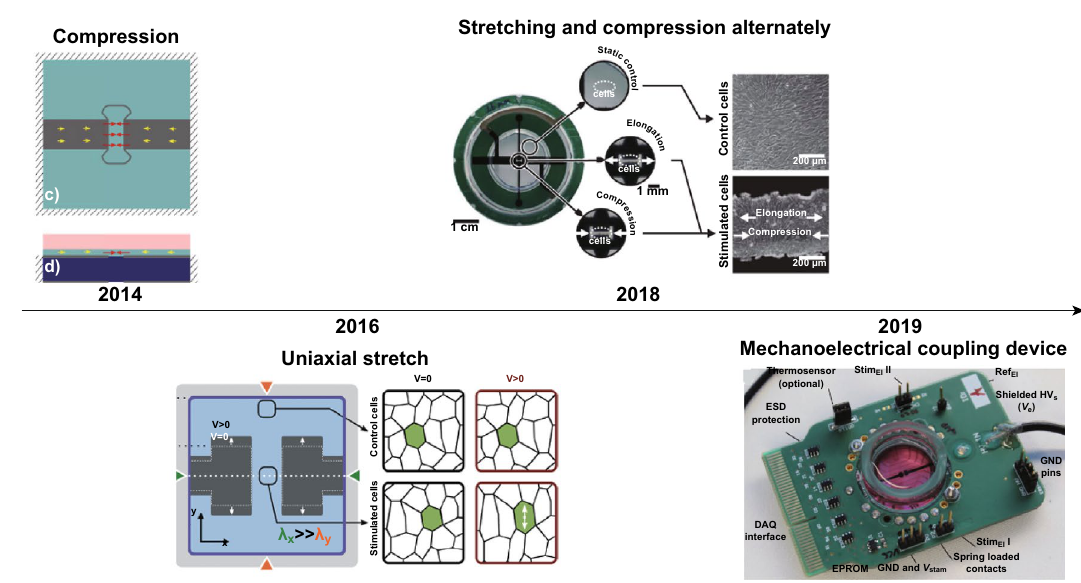
Fig. 6 The DEA devices for cellular stimulations. Uniaxial compression was proposed by Alexandre et al. in 2014, which harnesses stress in passive region of the DEA and stimulates the cells on top of the region. Adapted from Ref. [71] with permission. In 2016, they fabricated the DEA for uniaxial stretching of cells, and LECs were used to test the device. Adapted from Ref. [44] with permission. Poulin et al. proposed the active cell culture substrate which can produce complex strain patterns with extremely high-strain rates in 2018. Adapted from Ref. [78] with permission. In 2019, more advanced DEA-based bioreactor providing mechanoelectrical coupling stimulus is proposed. Adapted from Ref. [85] with